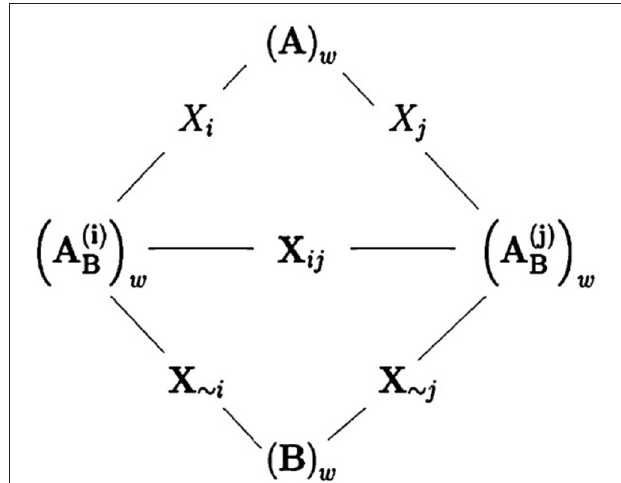
FIGURE 4 | A figure by courtesy of Saltelli et al. [38] showing the relationships between sampling matrices. The wth row of matrix A and the wth row of of matrix A ( i ) B are considered being separated by a step in the direction of X i . Similarly, the wth row of matrix A ( i ) B and the wth row of matrix B are considered separated by a step along the direction of X ∼ i . Finally, the wth row of